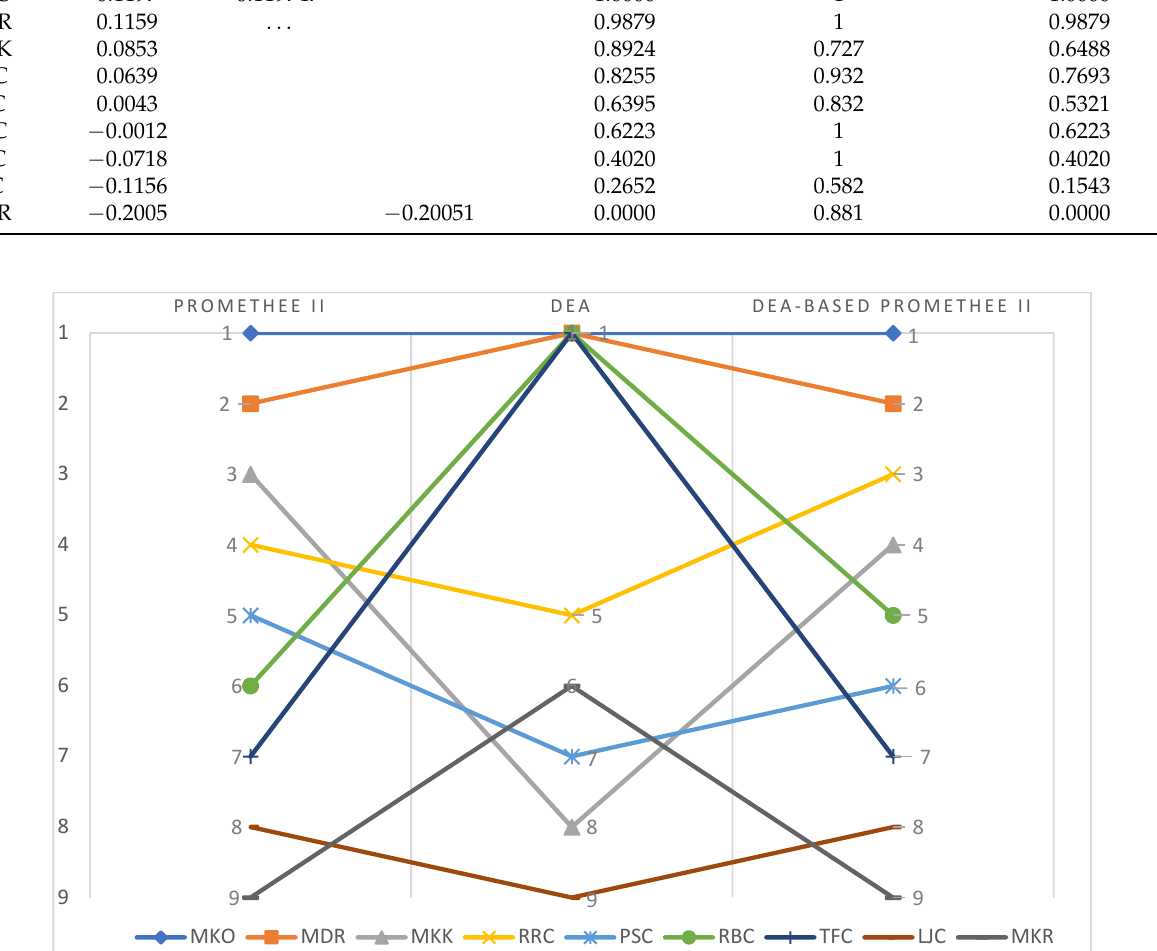
Figure 2. DCs ranking comparison with respect to PROMETHEE II, DEA, and DEA-based PROMETHEE II.